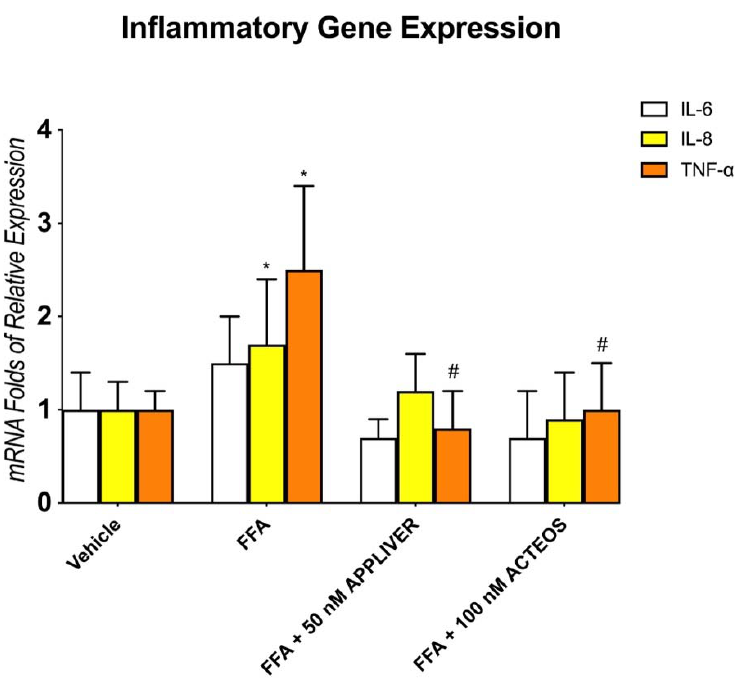
Figure 3. Assessment of anti-inflammatory properties of APPLIVER and ACTEOS on inflammatory cytokines mRNA expression. Gene expression analysis of pro-inflammatory cytokines (folds of mRNA expression vs. vehicle). Values presented are the mean ± SD of three independent experiments. * p < 0.05 vs. vehicle, # p < 0.05 vs. FFA. Abbreviations: FFA, free fatty acids; IL-6, interleukin-6; IL-8, interleukin-8; TNF- α , tumor necrosis—alpha.